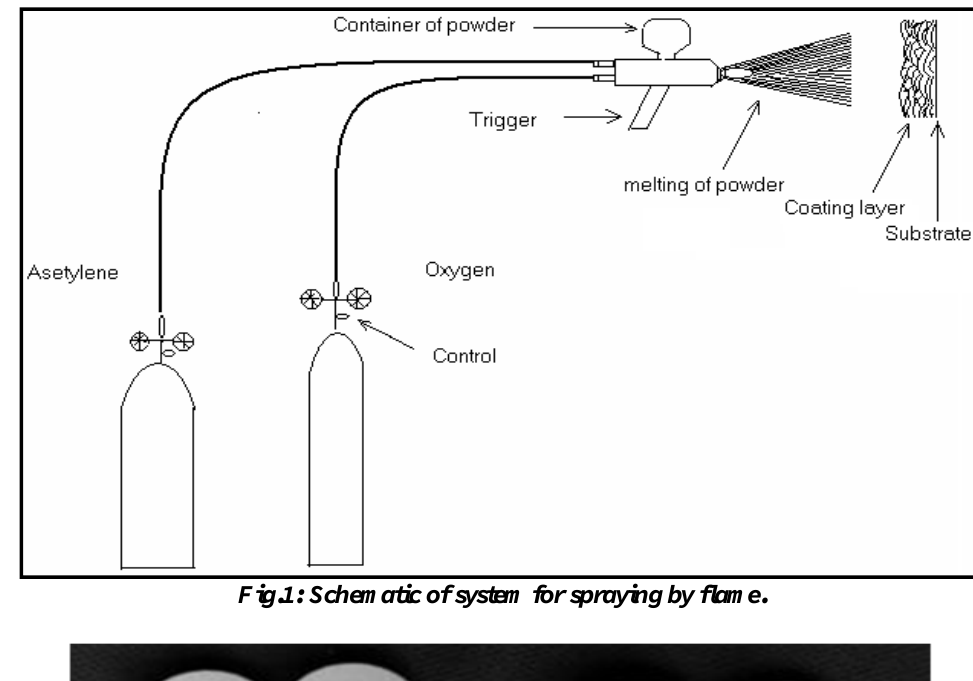
Fig.1: Schematic of system for spraying by flame.